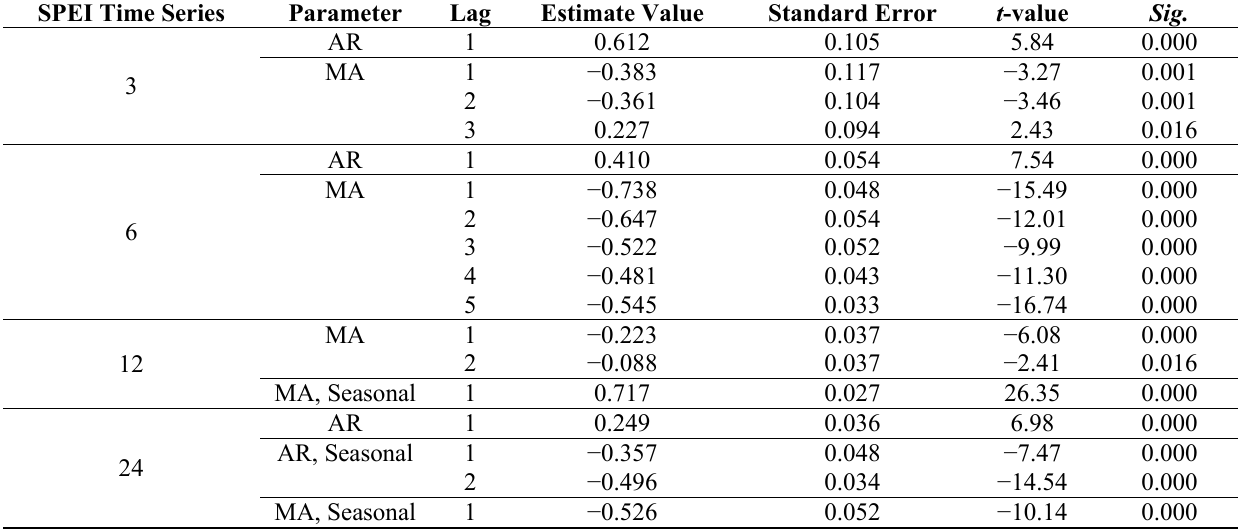
Table 4. Statistical analysis of autoregressive integrated moving average (ARIMA) model parameters, including the autoregressive (AR) and moving average (MA) orders with associated significance values at significance level < 0.05 for Al Ghazalah